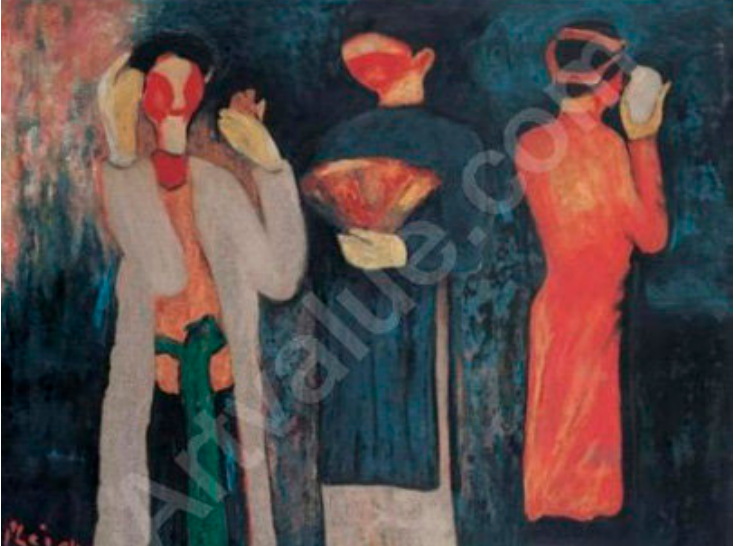
Figure A16. Truoc gio bieu dien (Cheo Actors)—Bui Xuan Phai. Auctioned at Sotheby’s, April 2008. The images were sourced from Tuoi Tre Newspaper (Ly 2008).